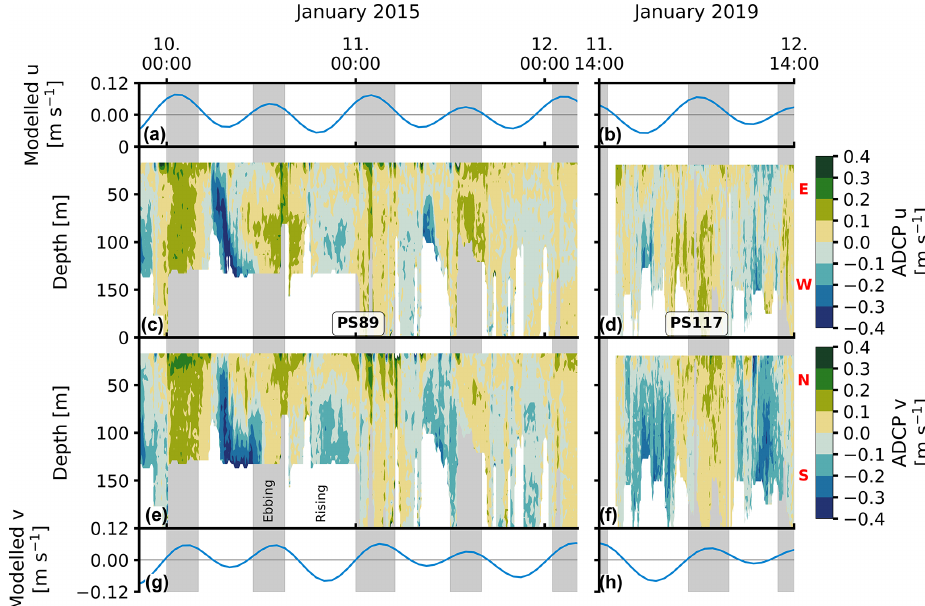
Figure 2. Current velocity for PS89 (a, c, e, g) and PS117 (b, d, f, h) . The modelled u component of the tidal currents is shown in (a) and (b) . The modelled v component is shown in (g) and (h) . Modelled tidal velocities are averaged over the full water column. The u component of the ADCP profile data is shown in (c) and (d) . The v component of the ADCP data is shown in (e) and (f) . Vertical grey-shaded areas indicate times of ebbing tide, here identified as times when the u and v components in the modelled tidal current are both positive, i.e. the direction of the current is north-east. Directions associated with the positive and negative values of the u and v components are indicated by the red letters next to the colour bars: N (north), S (south), E (east), and W